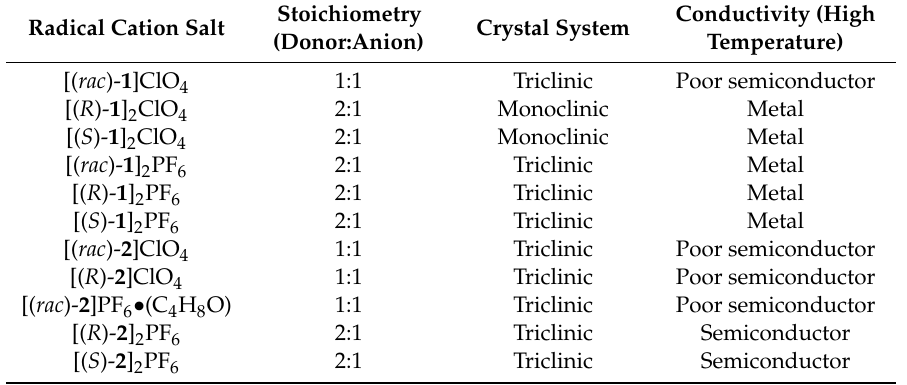
Table 6. Comparison between the radical cation salts of donors 1 and 2 with the ClO 4– and PF 6– anions.